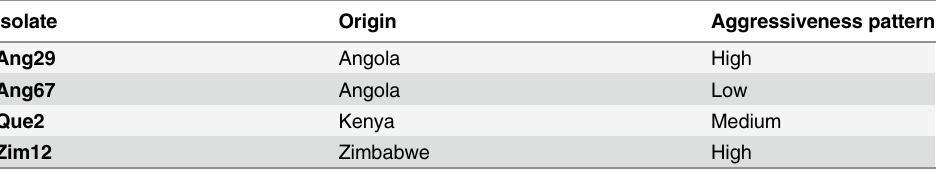
Table 1. Details on Colletotrichum kahawae isolates regarding its geographical origin and aggres- siveness pattern in Coffea arabica (var. Caturra).